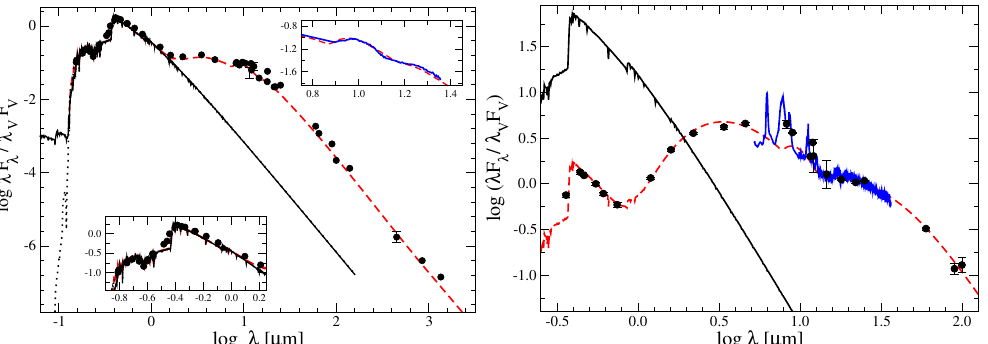
Figure 4. Observational and best fitting theoretical SEDs of two FSCMa group objects recently modeled using the radiation transfer code developed by Zakhozhay et al. [20]. The photometric data corrected for the interstellar extinction are shown with black circles. The best fitting theoretical SED are shown with red dashed lines. The fluxes are normalized to that in the V band; the wavelengths are shown in microns. Details of the modeling and parameters can be found in [21] for 3Pup ( left panel ) and in [22] for IRAS07080 + 0605 ( right panel ). Left panel: 3Pup. Black solid line shows the emergent stellar SED with added flux from the secondary component. The dotted line shows the stellar SED of the primary component only. The upper inset shows the 10 µ m region with the IRAS low resolution spectrum (blue line) and its detailed fit. The lower inset shows the agreement of the observed and model UV fluxes. The contribution from the secondary component shows up as a deviation from the black dashed line in the far UV. Right panel: IRAS 07080 + 0605. The photometric data and the best fitting model are shown by the same lines and symbols as for 3Pup. The blue line shows the Spiter Space Observatory spectrum. The emission features near λ ∼ 10 µ m produced by Polycyclic Aromatic Hydrocarbons were not attempted in the fitting process. The black line shows the SED of the star without the disk